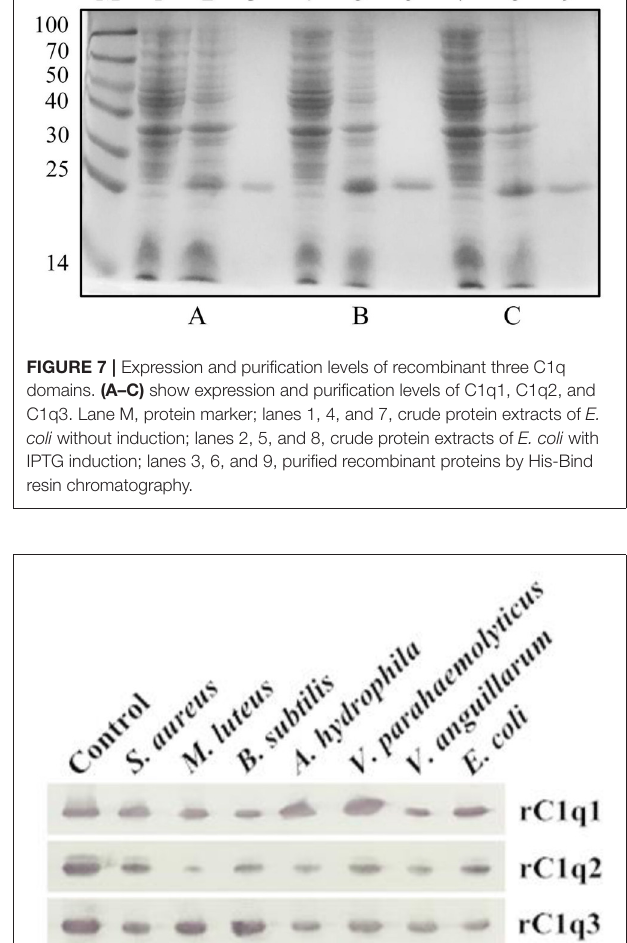
to the original level. In the V. parahaemolyticus stimulated